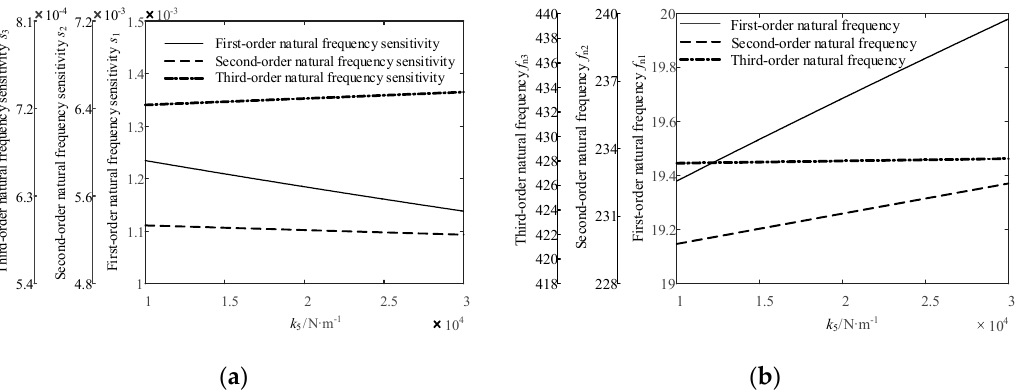
Figure 15. The variation law of the first three natural frequencies and their sensitivities of the jet system with the stiffness of the spring in the gun head. ( a ) Variation law of natural frequency sensitivity. ( b ) Variation law of natural frequency.